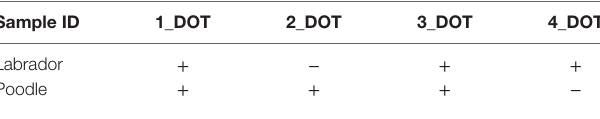
TaBle 3 | Indication ( + = correct; − = false) of dog at first contact with synthetic air samples with potential biomarker for lung cancer. sample iD